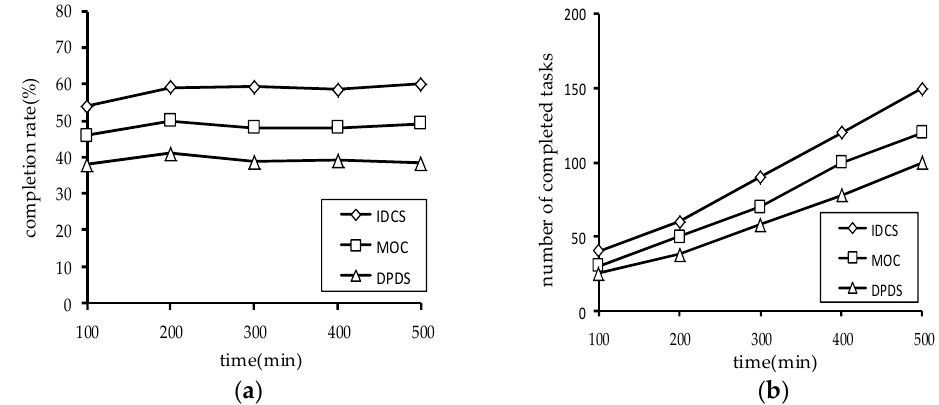
Figure 11. Performance comparisons of the three algorithms on the dynamic task set: ( a ) Comparison of task completion rate; ( b ) comparison of the number of tasks completed.